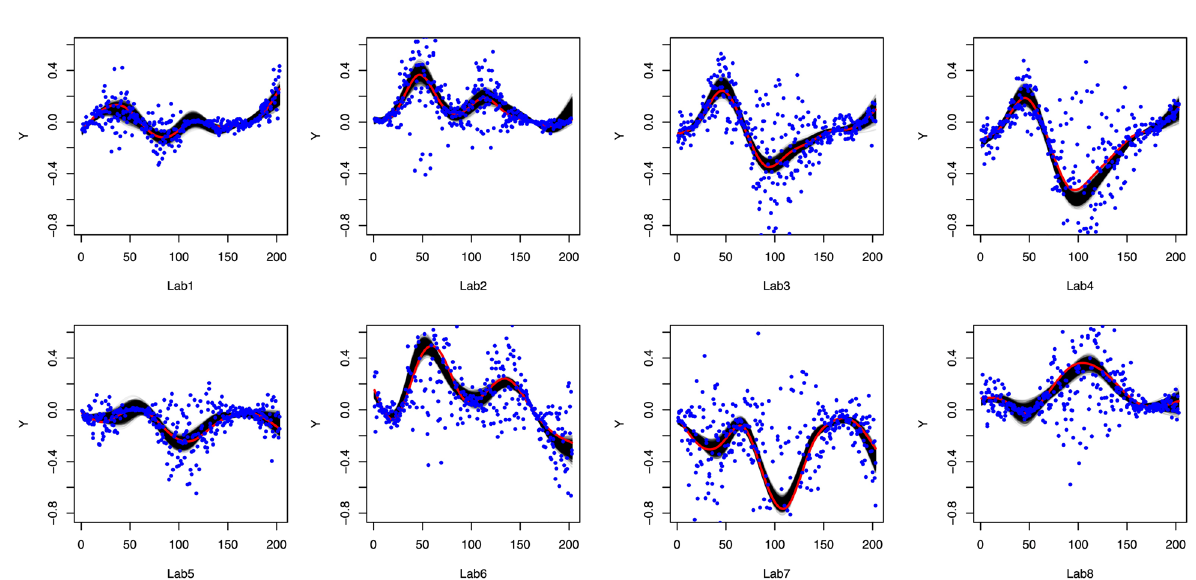
Figure 4. The simulation results of the statistical design with σ it / | µ it | = 1 . The posterior curves are in black, the truth line is a red line, and simulated observations are blue